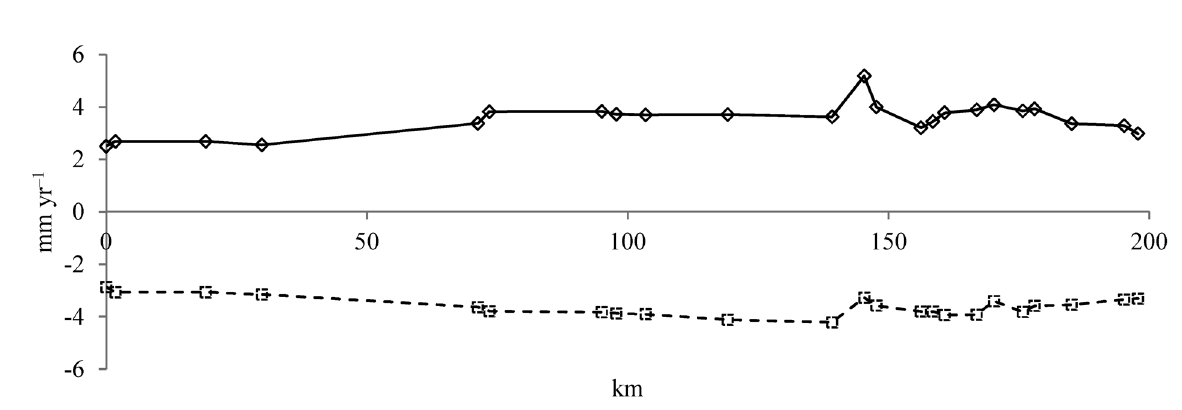
Fig. 2. Profile of changes (solid line) and v (dashed line) in apparent VVs of the benchmarks (BMs) solved from Eq. (9) along levelling loop VII in Saaremaa starting from the wall BM SR147 (Fig. 1). Here